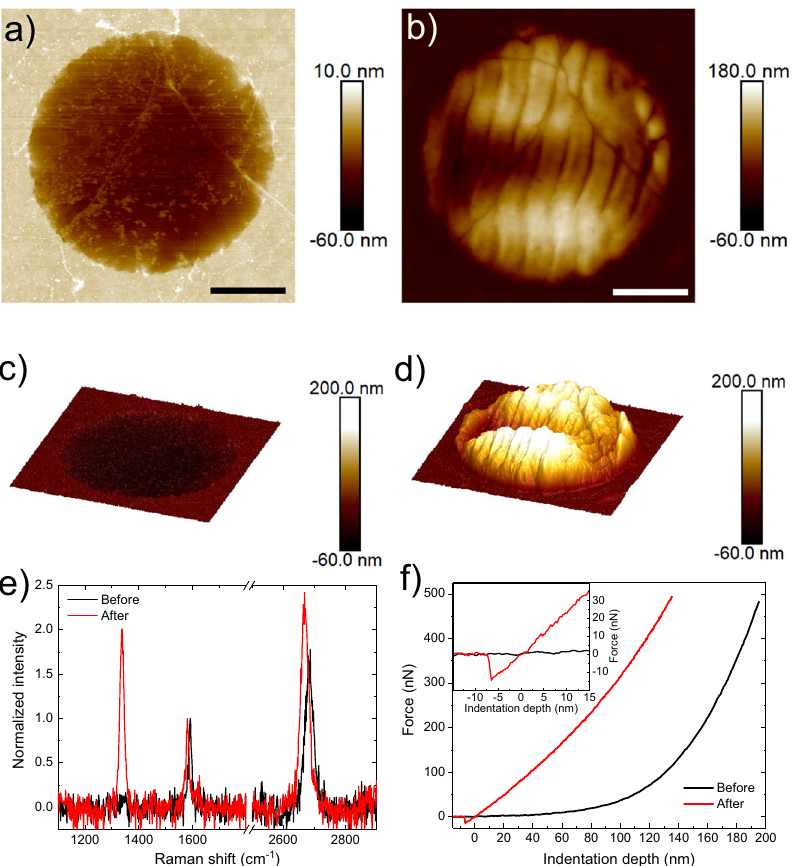
Fig. 1 Experimental results of a membrane irradiated with dose of 2.4 · 10 11 pJscm − 2 per point. AFM images showing the membrane a before and b after optical forging. Panels c and d show 3D-rendered images of a and b with the same colorscale. Raman spectra e and force curves f showing the graphene before (black) and after (red) forging. Note that in panels c and d the vertical dimension is sixfold enhanced compared to the lateral dimension. Scale bars are 1